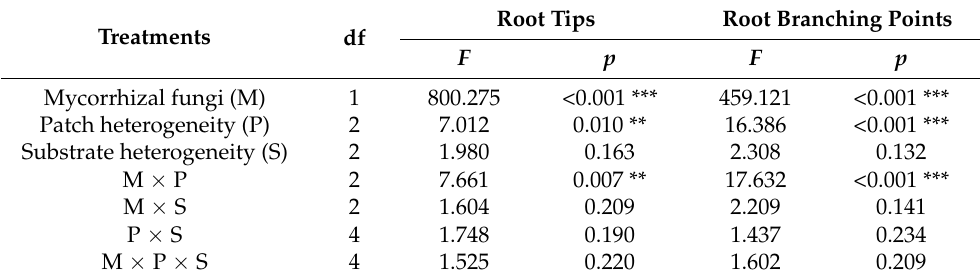
Table 4. Three-way ANOVA for the effect of mycorrhizal fungus (M + vs. M − ), patch heterogeneity (Homo vs. Hetl vs. Hets), and soil substrate heterogeneity (GL vs. GF vs. GH) on root tips and branching points.